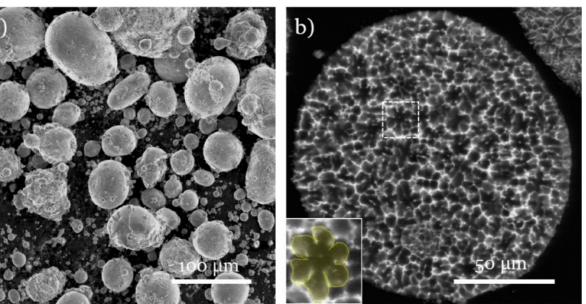
Figure 2. Gas atomized WE43 powder: ( a ) SEM micrograph; ( b ) SEM/BSE micrograph to show the cross-section [62].